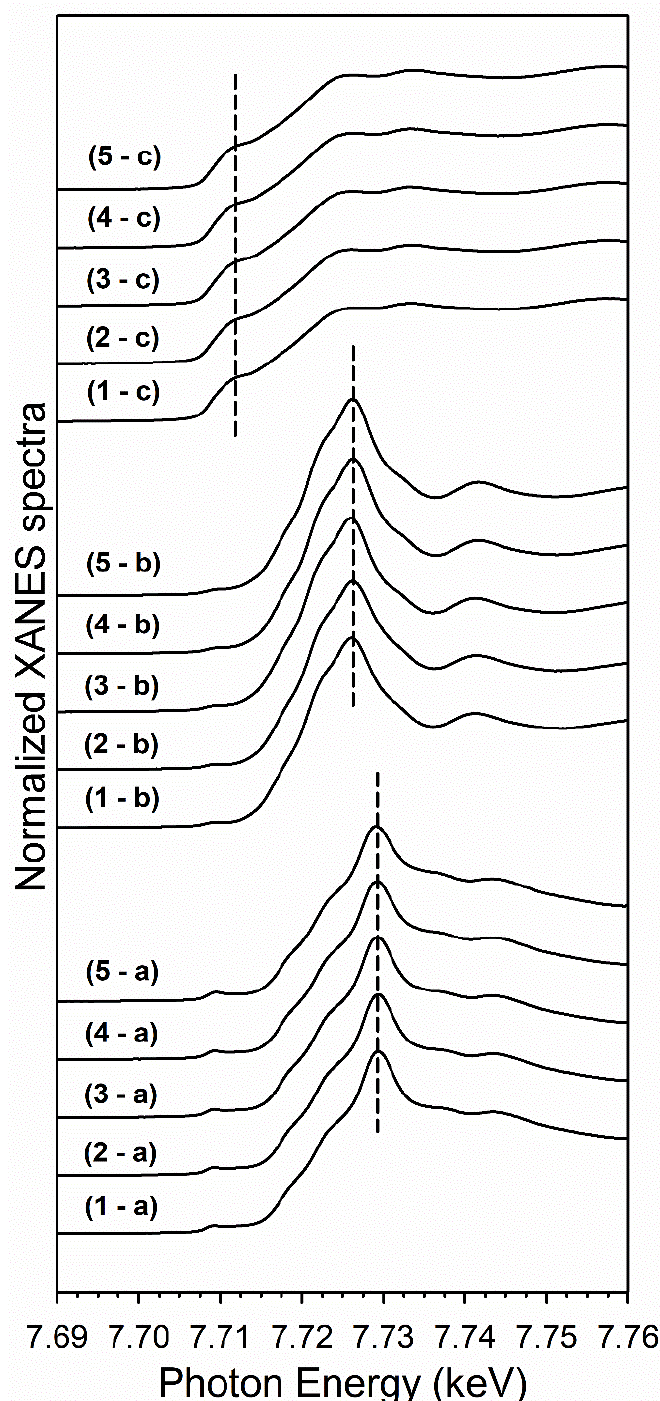
Figure 6. Co K-edge XANES spectra: ( a ) the initial point consisting of primarily Co 3 O 4 ; ( b ) the point of maximum CoO content; and ( c ) the final spectrum consisting of primarily Co 0 for ( 1 ) 25%Co / Al 2 O 3 , ( 2 ) 25%M (M = 5%Ni-95%Co) / Al 2 O 3 , ( 3 ) 25%M (M = 10%Ni-90%Co) / Al 2 O 3 , ( 4 ) 25%M (M = 25%Ni-75%Co) / Al 2 O 3 , and ( 5 ) 25%M (M = 50%Ni-50%Co) / Al 2 O 3 .